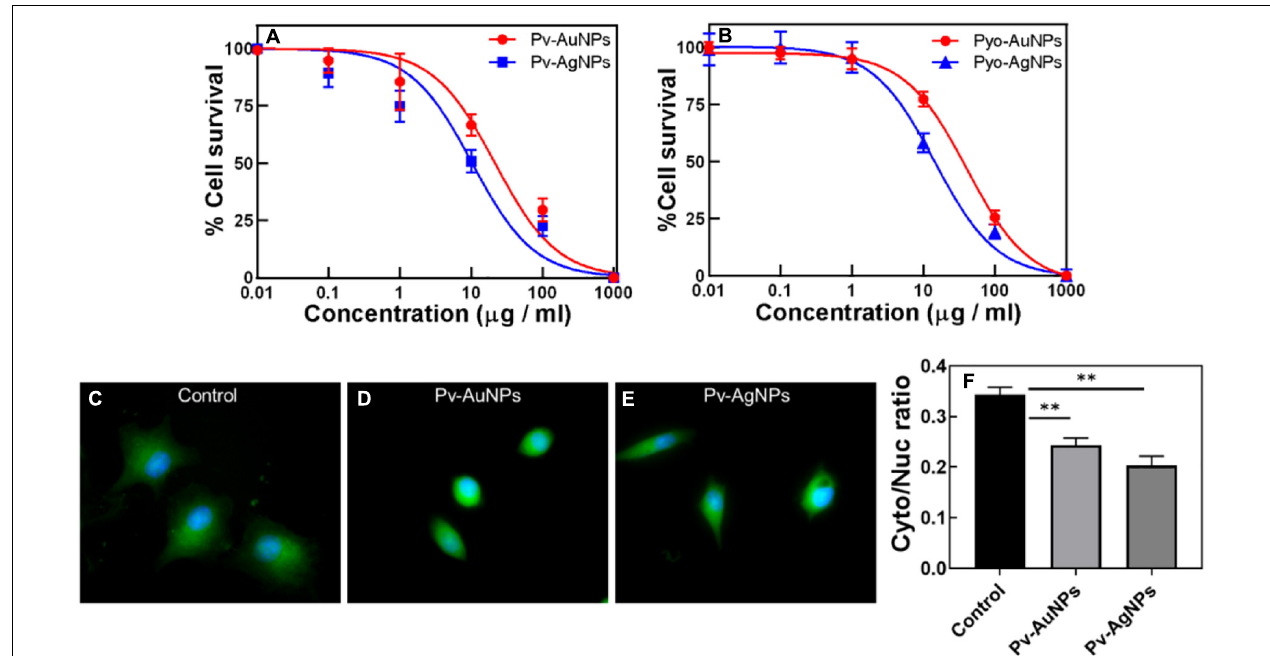
FIGURE 5 | Anticancer activity of Pv-PNPs and Py-PNPs. (A) Cytotoxicity assay performed on A549 cells after treatment with Pv-AuNPs (red curve) and Pv-AgNPs (blue curve). (B) Cytotoxicity assay performed on A549 cells after treatment with Py-AuNPs (red curve) and Py-AgNPs (blue curve). (C,D) Effect of Pv-AuNps and Pv-AgNps on the cell and nuclear size in A549 cells. (C) Maximum intensity projection (MIP) of the composite image (overlay of polymerized actin and the nucleus) of untreated A549 cells showing well-defined cell body (green) and nucleus (blue) (Rai et al., 2021). MIP images of A549 cells treated with Pv-AuNPs (D) and Pv-AgNPs panel (E) showing reduced cell and nuclear size. (F) karyoplasmic ratio from control (untreated) and Pv-AuNPs and Pv-AgNPs treated cells showing reduction due to Pv-PNPs treatment ( P = 0.0082 and 0.004). ∗∗ indicates p value is statistically significant and is less than